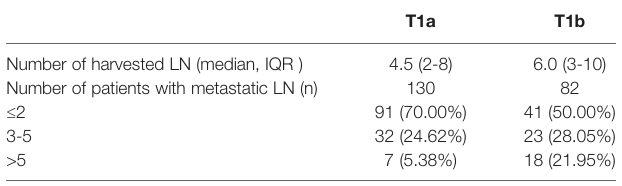
TABLE 1 | Pathologic characteristics of central lymph